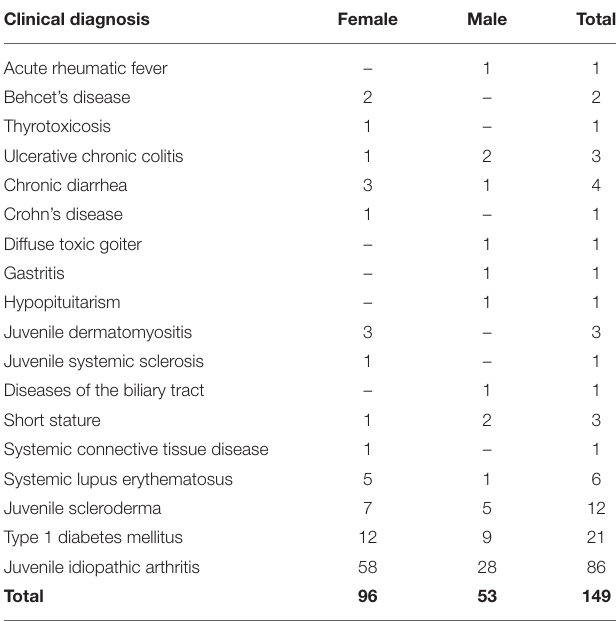
TABLE 1 | Clinical characteristics of